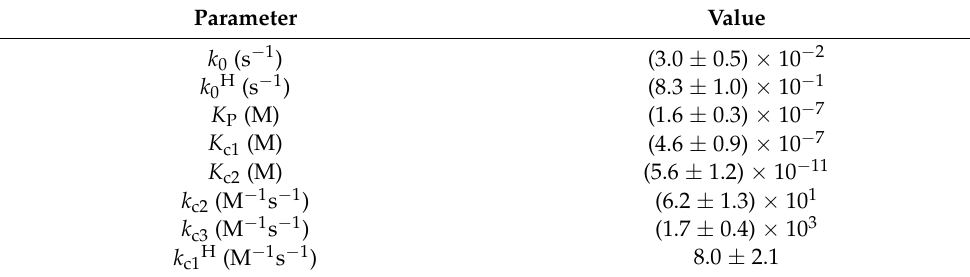
Figure 5. pH dependence of the peroxynitrite isomerization rate constant in the absence of CO 2 /HCO 3 − /CO 32 − ( A ), in the presence of 5.0 × 10 − 1 M CO 2 /HCO 3 − /CO 32 − ( B ), and in the presence of 3.0 × 10 − 2 M CO 2 /HCO 3 − /CO 32 − ( C ). In all three panels, the continuous lines correspond to k obs , as defined in Equation (3), under different conditions (i.e., [L] = 0 ( A ), [L] = 5.0 × 10 − 1 M ( B ), [L] = 3.0 × 10 − 2 M ( C ), employing the parameters reported in Table 3. In ( A , B ), the open circles correspond to experimental data obtained from the literature [36] on the peroxynitrite isomerization rate constants as a function of pH under the conditions described above. The continuous lines were obtained according to Equation (3) by the non-linear least-squares fitting of data. In ( C ), the open circles correspond to values of k obs in the presence of 3.0 × 10 − 5 M Dr -Nb(III) in the absence of CO 2 /HCO 3 − /CO 32 − at different pH values (present study). Data shown in ( C ) indicate that, at pH 5.8, the efficiency of the heme protein (at the indicated concentration) is higher than that of the CO 2 /HCO 3 − /CO 3 2 − system, while at pH 8.5, the efficiency is lower. Table 3. Values of the parameters fitting data with Equation (3).